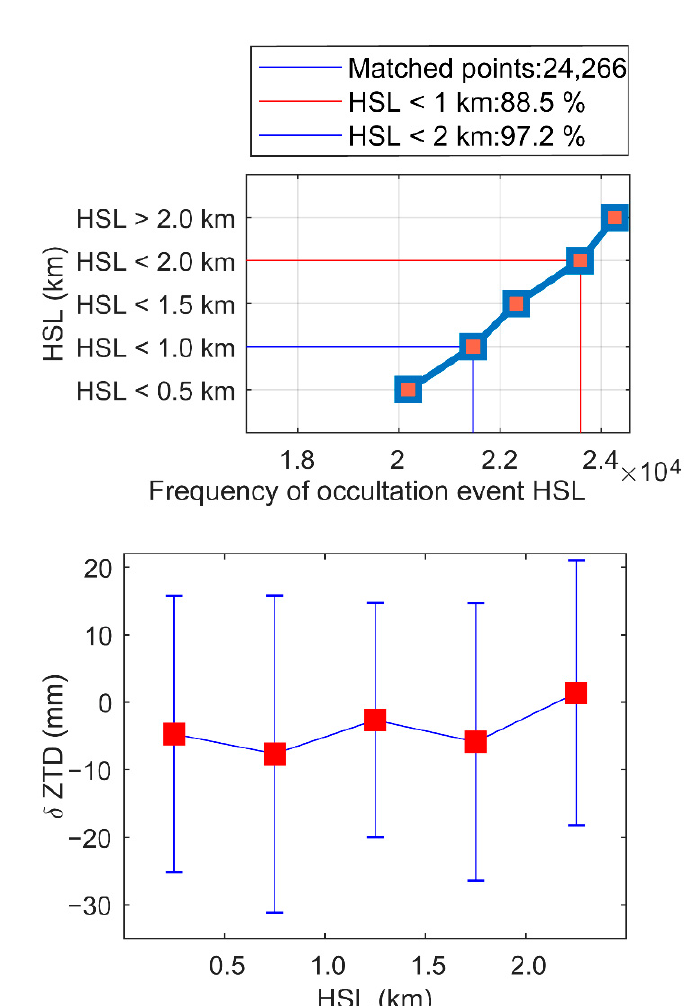
Figure 10. HSL variations in ( a ) frequency; and ( b ) residual ZTDs of matched atmPrf and gnsZTD in 2008.